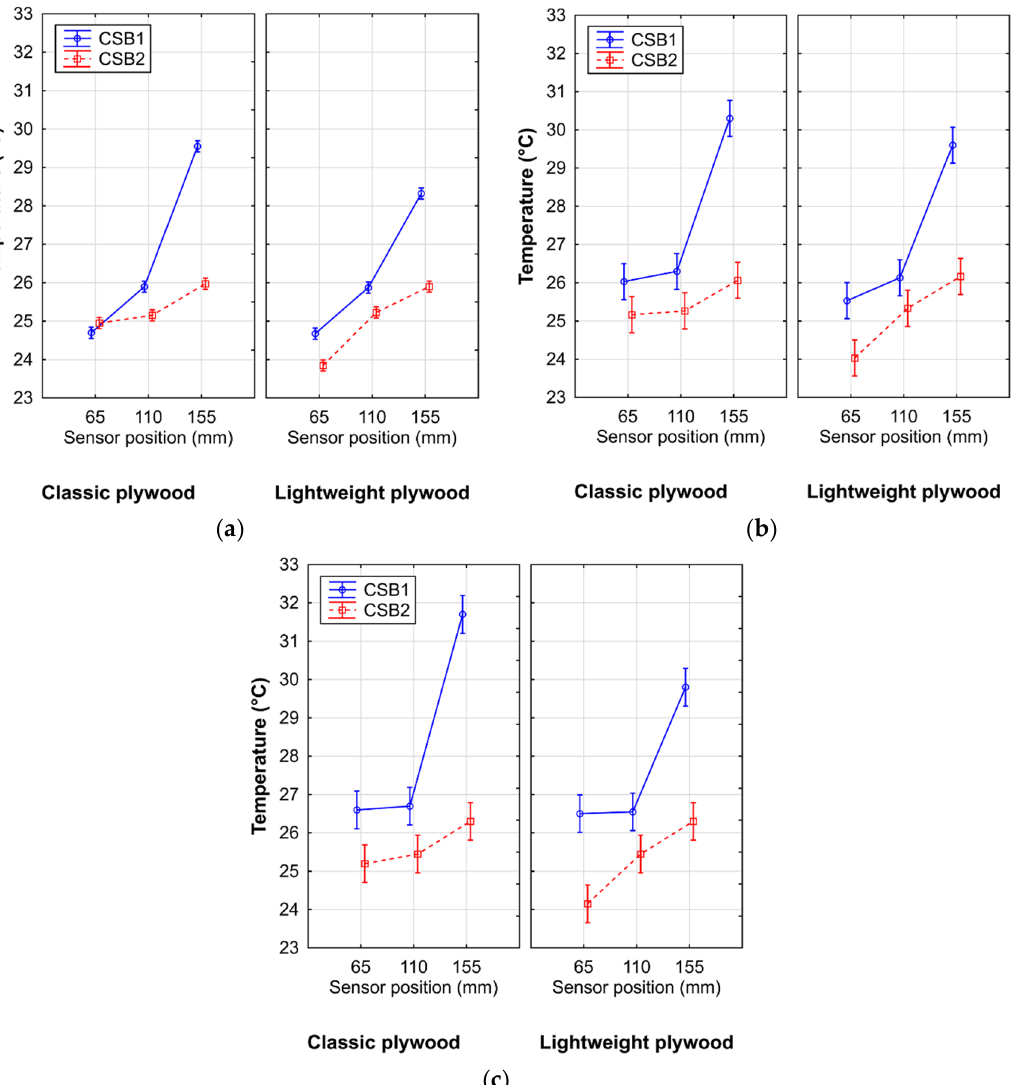
Figure 10. Dependence between the surface temperature of the circular saw blade and the position of the sensor when cutting classic and lightweight plywood at rotation speed n = 4150 min −1 : ( a ) feed speed v f = 14 m/min; ( b ) feed speed v f = 21 m/min; ( c ) feed speed v f = 28 m/min.